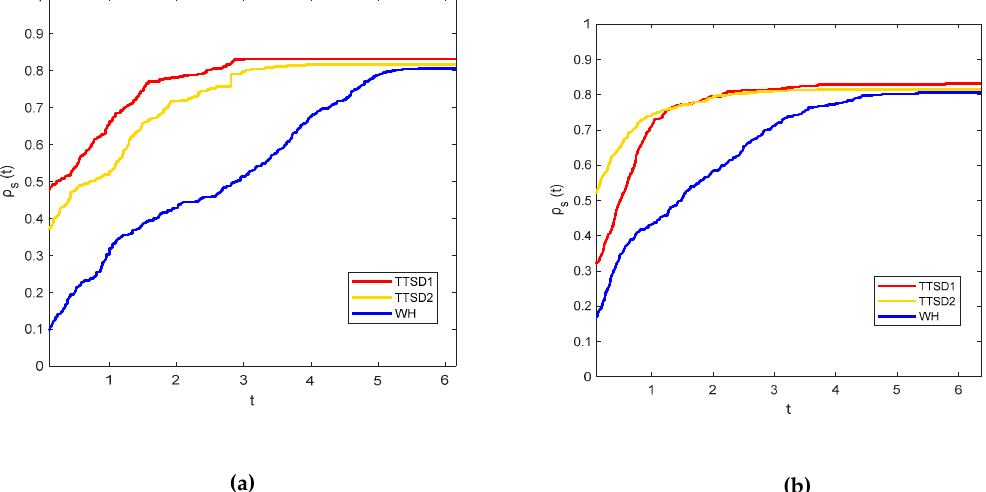
Figure 2. Performance profile using exact line search procedures between three-term iterative methods based on the ( a ) number of iterations evaluation; ( b ) CPU time.